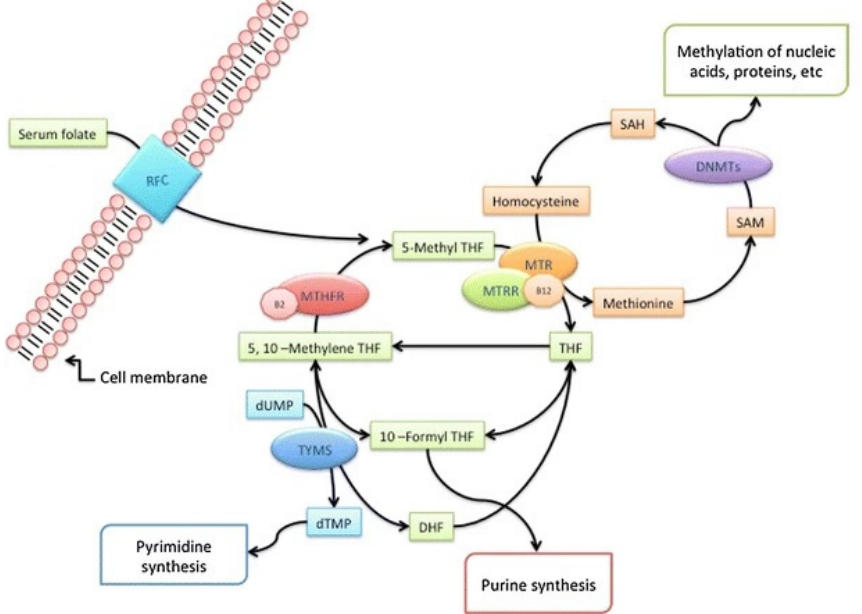
Figure 1. Overview of the folate metabolic pathway (adapted from Coppedè 2015 [20]RightsLink No. 5490861127574). Dietary folates provide one-carbon units for DNA synthesis and methylation